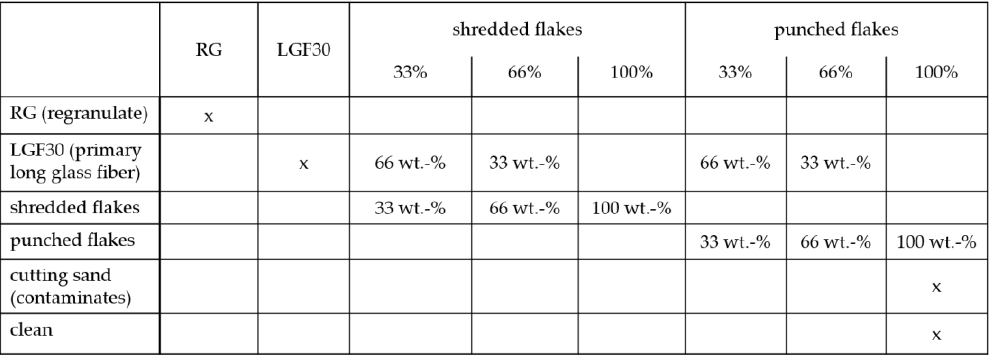
Figure 4. Summary and overview of the material variants investigated.